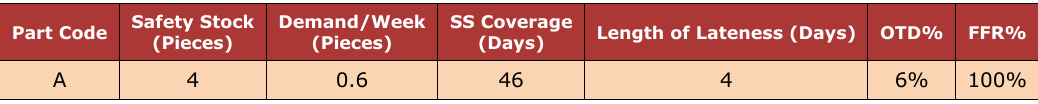
Table 8. Safety stock simulation model-sample 1